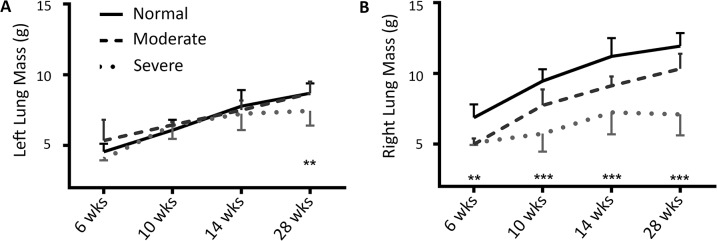
Lung mass.(A) Left and (B) right lungs mass at each time point is shown. Statistical significance is indicated: **p<0.01, ***p<0.001.